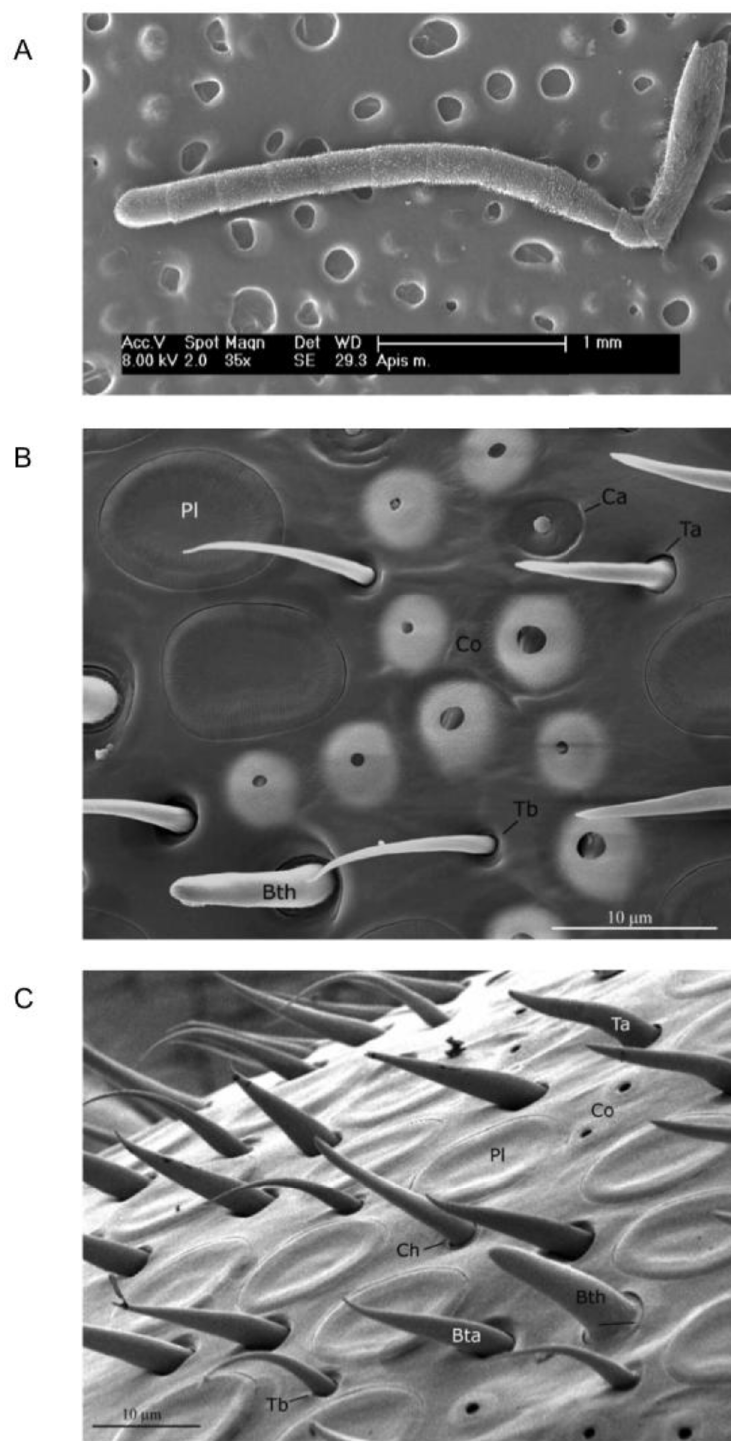
Figure 4. Scanning electron microscopy (SEM). ( A ) Low-magnification SEM image of the ventral view of A. mellifera left antenna. Segments from 3rd to 10th were imaged for subsequent counting of sensilla. ( B ) and ( C ) Scanning electron micrographs of the antenna of A. mellifera forager. Pl, sensillum placodeum; Ta, sensillum trichodeum type a; Tb, sensillum trichodeum type b; Ba, sensillum basiconicum thick; Bb, sensillum basiconicum tapered; Ch, sensillum chaeticum; Co, sensillum coeloconicum; Ca, sensillum campaniformium. (From